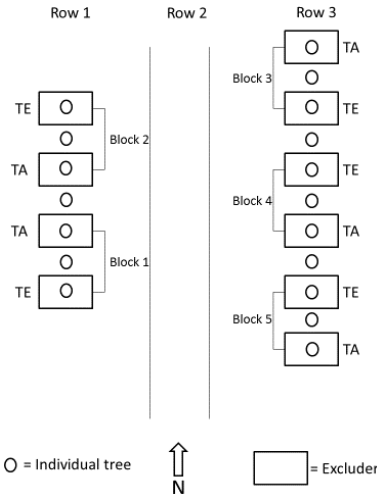
Figure 1. Diagram of study site showing treatment design and block layout for 100% throughfall exclusion (TE) and ambient throughfall (TA) treatments.